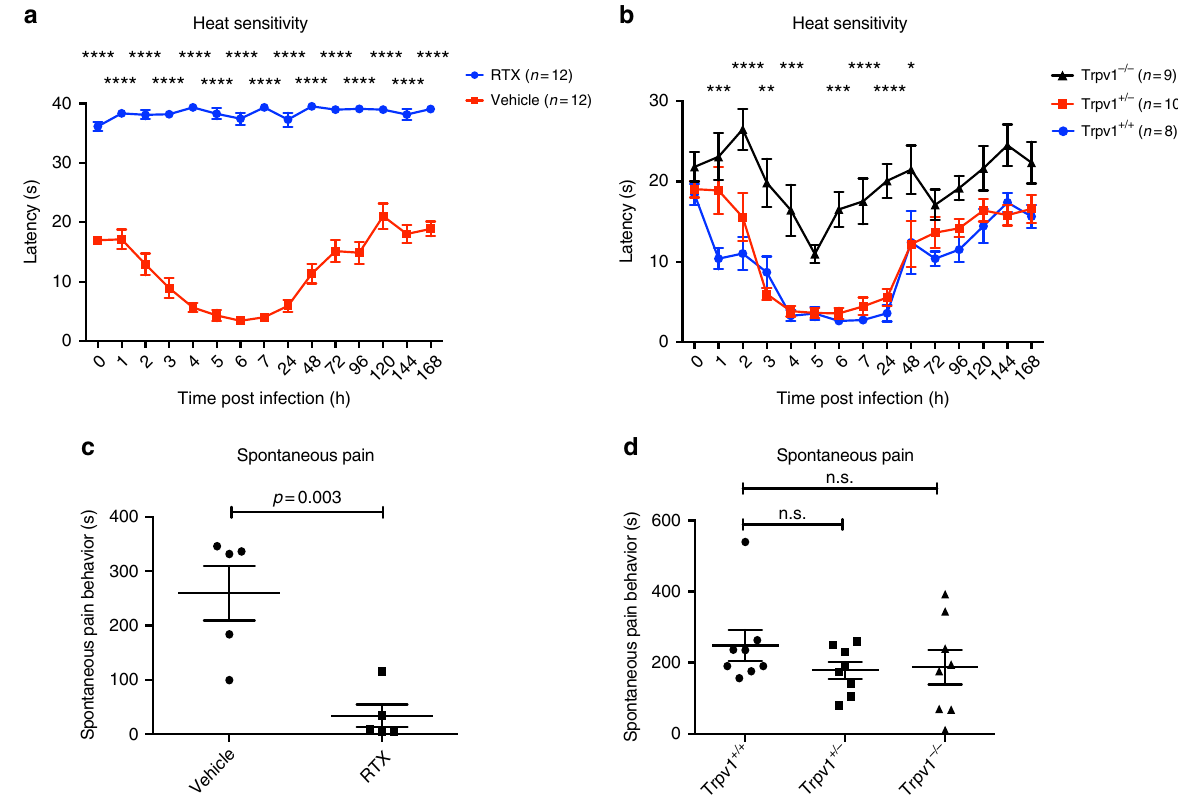
Fig. 5 Trpv1 mediates heat hyperalgesia during S. aureus infection. a Heat hyperalgesia was measured by the Hargreaves ’ radiant heat test in resiniferatoxin (RTX) vs. vehicle-treated mice following S. aureus infection (1 × 10 6 CFU, USA300). Forty seconds is the maximum cutoff for this assay. n = 12 mice per group. p values, two-way ANOVA with Sidak ’ s post-test. b Heat hyperalgesia measured in Trpv1 − / − compared to Trpv1 +/ − or Trpv1 +/+ littermates following S. aureus infection. Statistical comparisons shown: Trpv1 − / − vs. Trpv1 +/+ littermates. p values, two-way ANOVA with Tukey ’ s post-test. n = 8 – 10 mice per group. c Spontaneous pain was quanti fi ed over 60 min in RTX or vehicle-treated mice infected with S. aureus (USA300, 5 × 10 8 CFU). n = 5 mice per group. p values by unpaired t test. d Spontaneous pain was quanti fi ed over 60 min in Trpv1 − / − mice and littermate (Trpv1 +/ − , Trpv1 +/+ ) controls in S. aureus - infected mice (USA300, 5 × 10 8 CFU). n = 8 mice per group. a , c N = 2 replicates; b , d N = 3 replicates each. p values, one-way ANOVA, Tukey ’ s